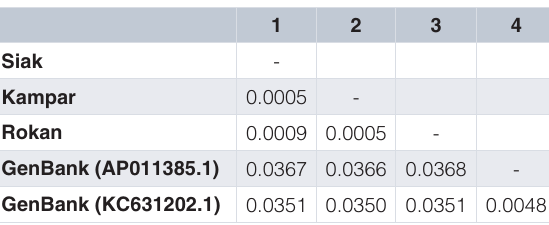
Table 2. Nucleotide distances among the